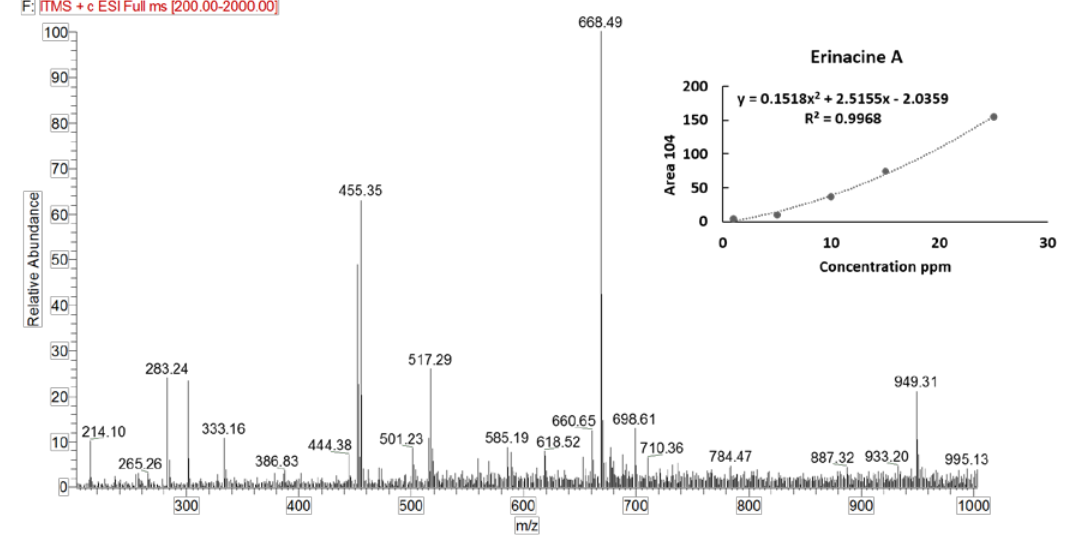
Figure 4. ESI/MS spectrum of Erinacine A. Panel (top, right) reports calibration curves and linear regression curve for Erinacine A.